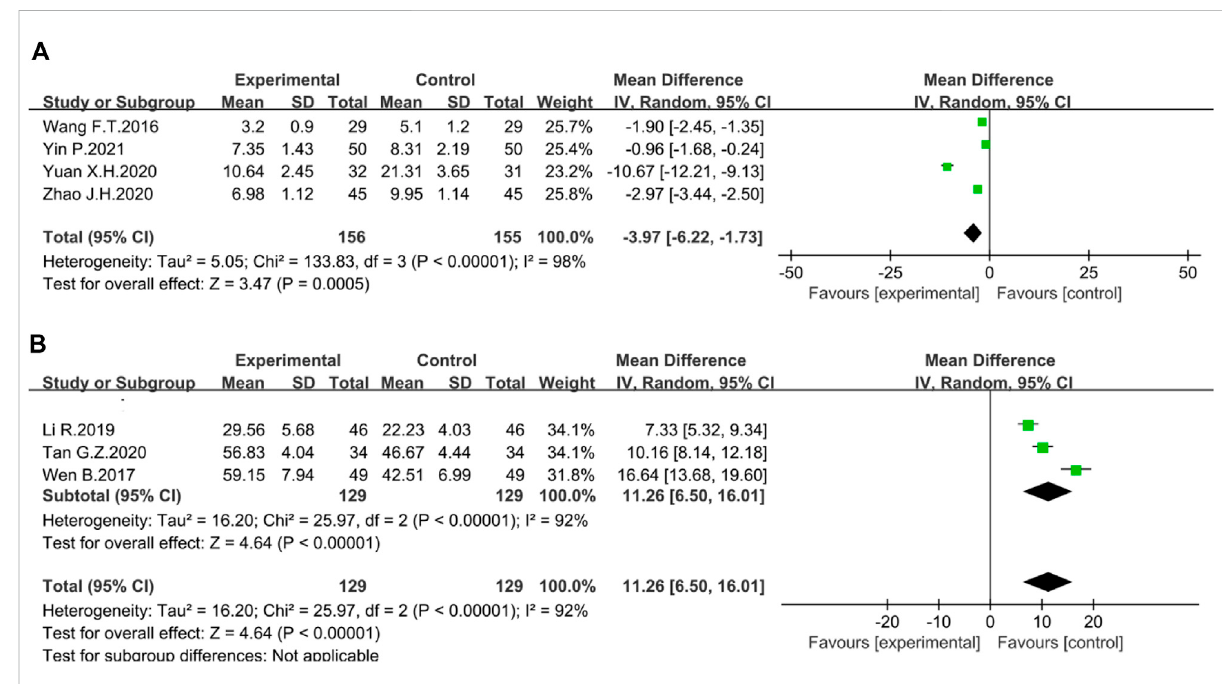
FIGURE 11 Forest plot displaying the results of the Meta-analysis for in fl ammation-related cytokines and protein. The results of (A) CRP; (B)